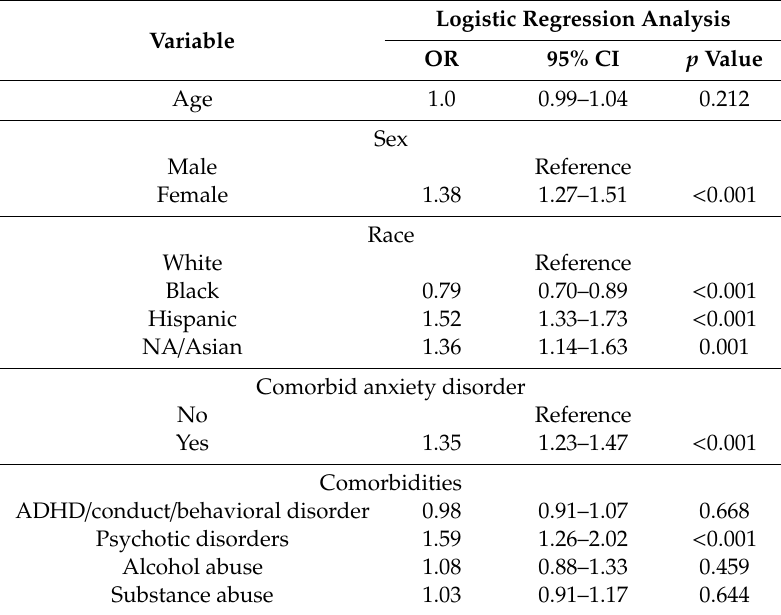
Table 2. Predictors of suicidal behaviors in bipolar depression